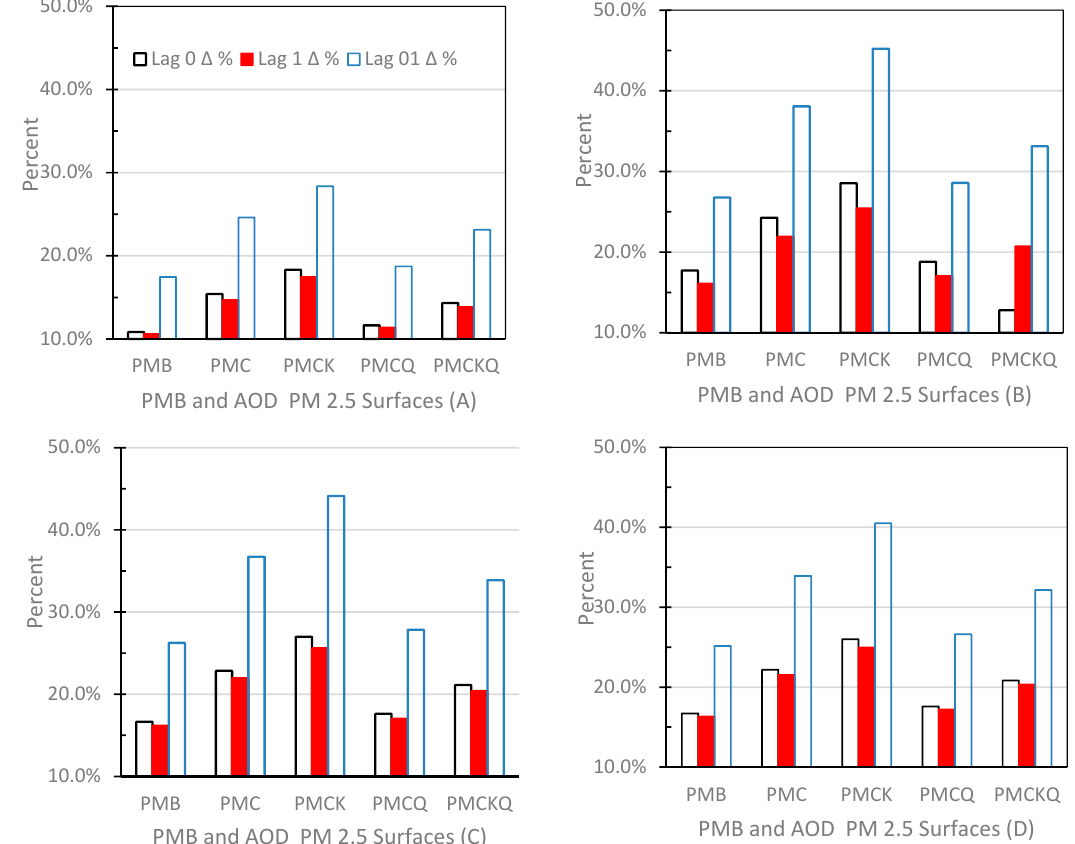
Figure 6. Percent change between warm and cold season Odds Ratios (ORs) for PMB and the four experimental aerosol optical depth (AOD)-PM 2.5 concentration surfaces at lag days of 0, 1 and 01: ( A ) ED asthma (top left panel), ( B ) IP asthma (top right panel), ( C ) IP MI (bottom left panel) and ( D ) IP HF (bottom right panel).